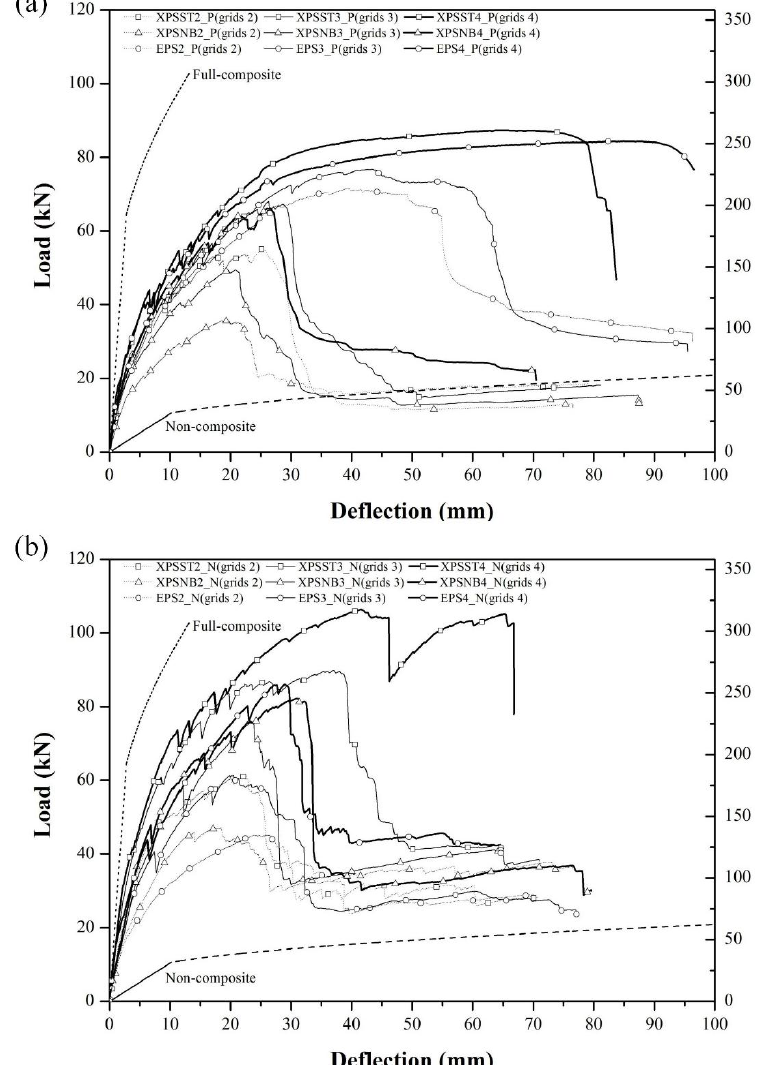
Figure 6. Load-deflection curve of specimens subjected to ( a ) positive load; and ( b ) negative